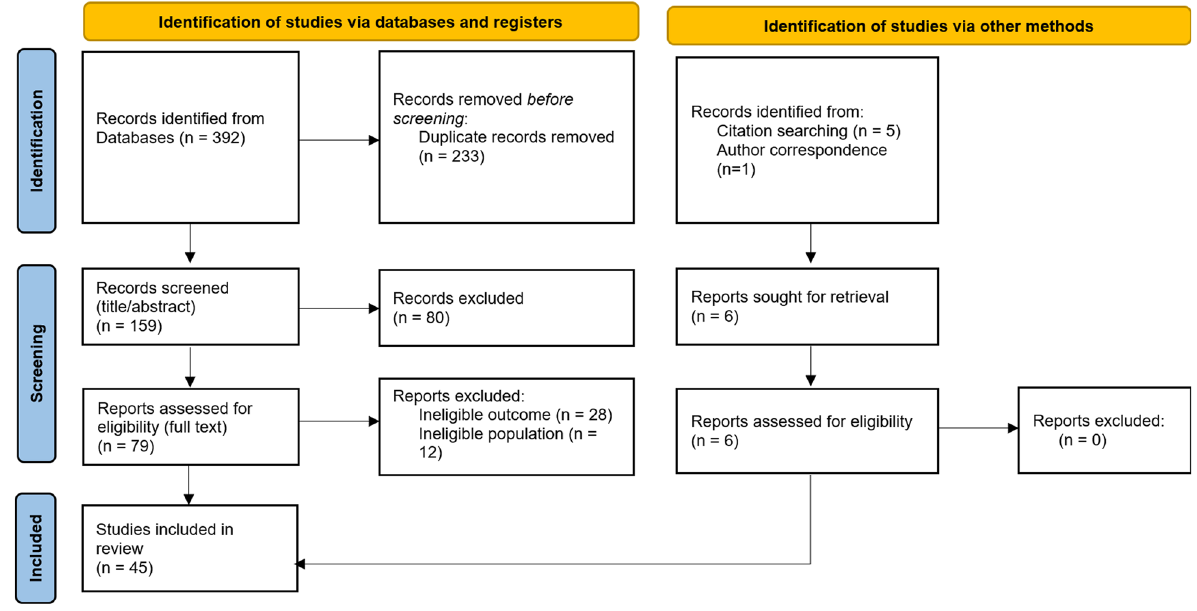
Fig. 1 Summary of search